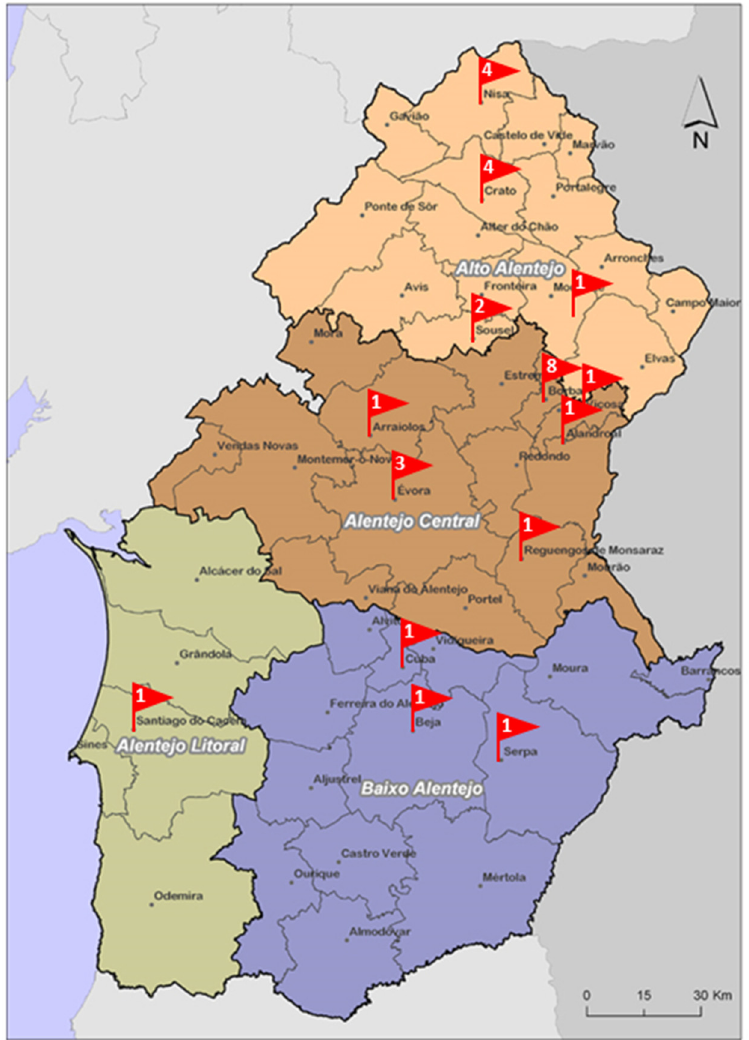
Figure 1. Number of brands assessed per Alentejo region.